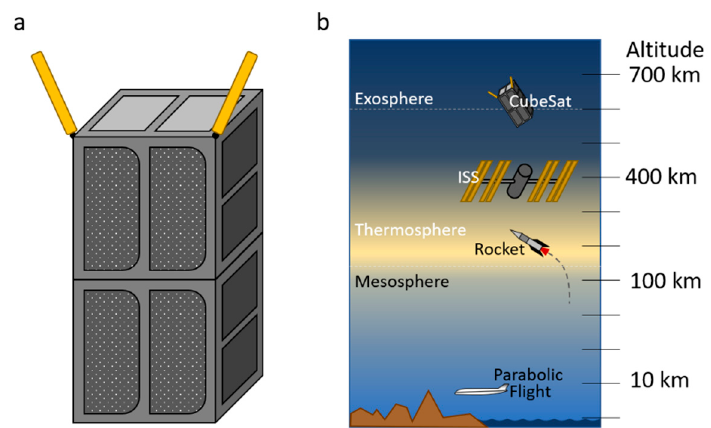
Figure 4. Schematic representation of ( a ) a CubeSat, a modular miniaturized satellite for Space research, composed of two units, with yellow antennas; ( b ) altitude in km of orbiting (CubeSats, ISS) and non-orbiting (sounding rockets, parabolic flights) facilities and atmospheric zones: the majority of CubeSats orbit at an altitude between 350 and 700 km, but they can be at lower or higher orbits; the International Space Station (ISS) orbits at an altitude of about 400 km; sounding sockets typically reach an altitude of 250–350 km; parabolic flights reach an altitude of 7 km.